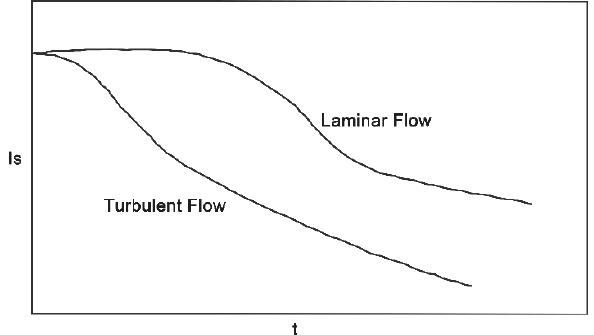
Figure 8. Variation of the intensity of segregation with mixing time (Is = 0 represents completely homogeneous mixing).